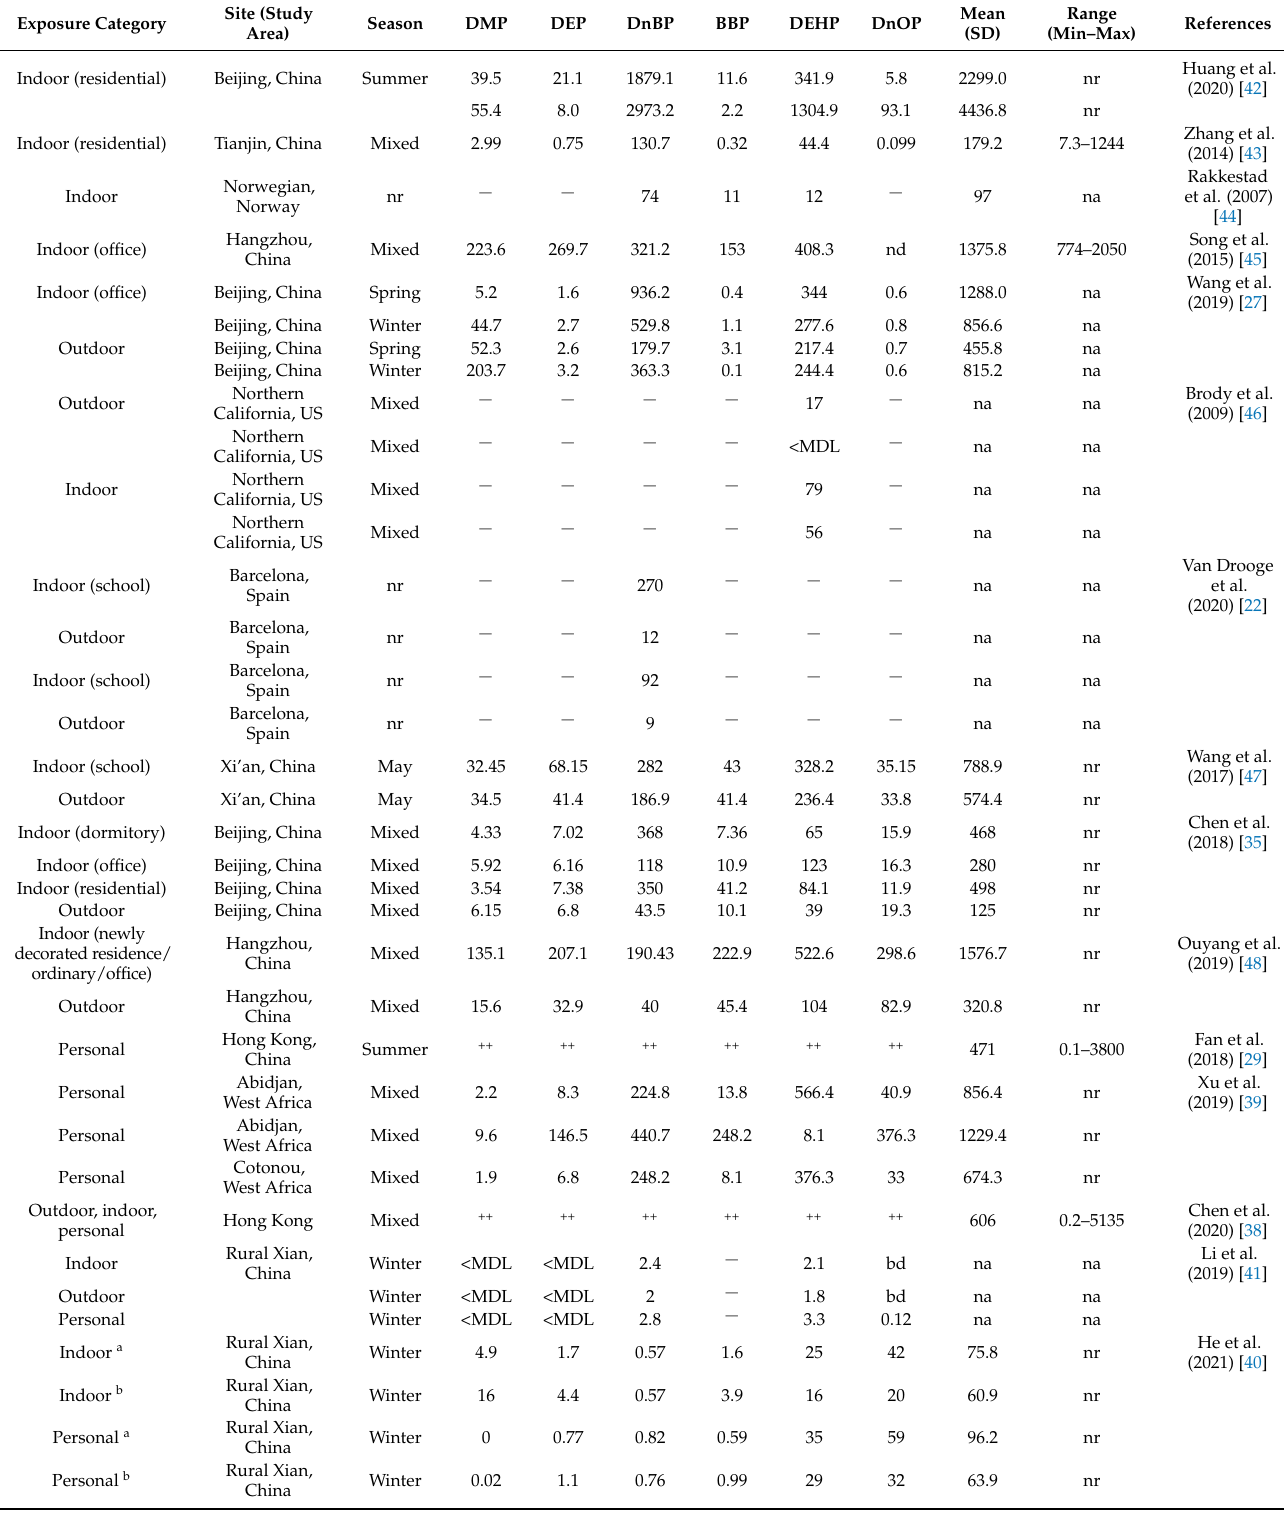
Table 2. Global comparison for particle-phase PAEs in residential indoor (along with concurrent outdoor) and (or) personal PM 2.5 exposure (unit: ng/m 3 ). Mean values of each PAE congener were